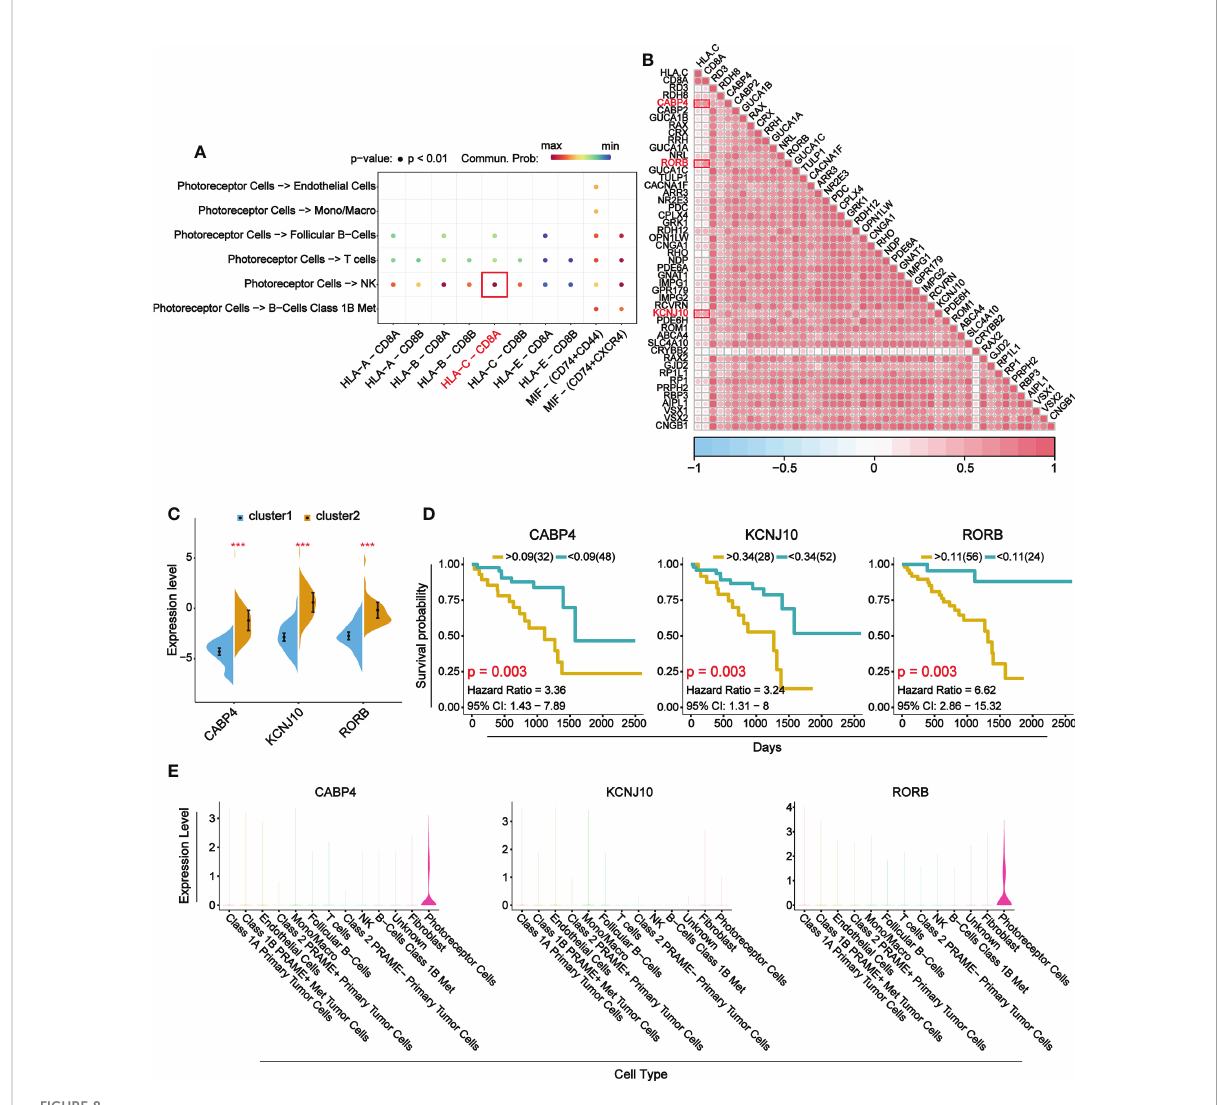
FIGURE 8 Main target genes of B7 family. (A) Receptor ligand pairs in which photoreceptor cells interact with immune-related cells. (B) Correlation analysis between receptor-ligand pair genes and DEGs in visual perception function. (C) The comparison of mRNA expression of top 3 DEGs between high and low expression group of B7 family. (D) Prognosis analysis of top 3 DEGs. (E) Violin plots show the expression levels of the top 3 DEGs in 13 cell types. *P < 0.05, **P < 0.01, and ***P <